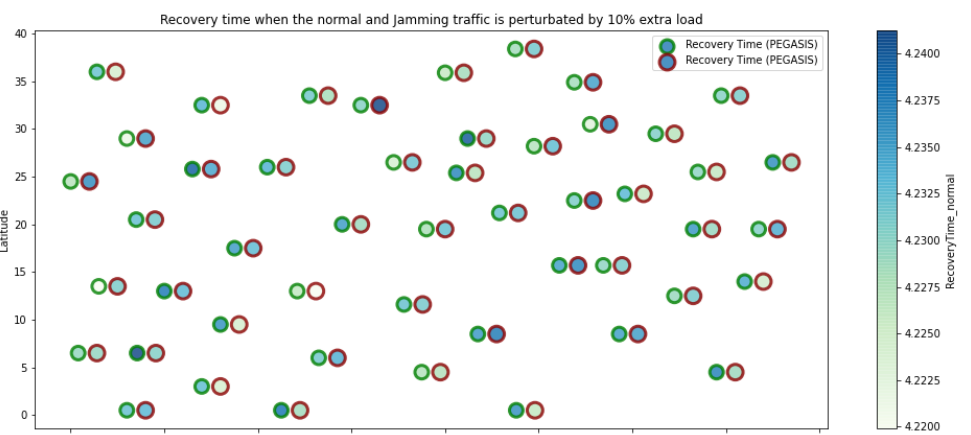
Figure 11. PEGASIS retransmissions under normal conditions and jamming.